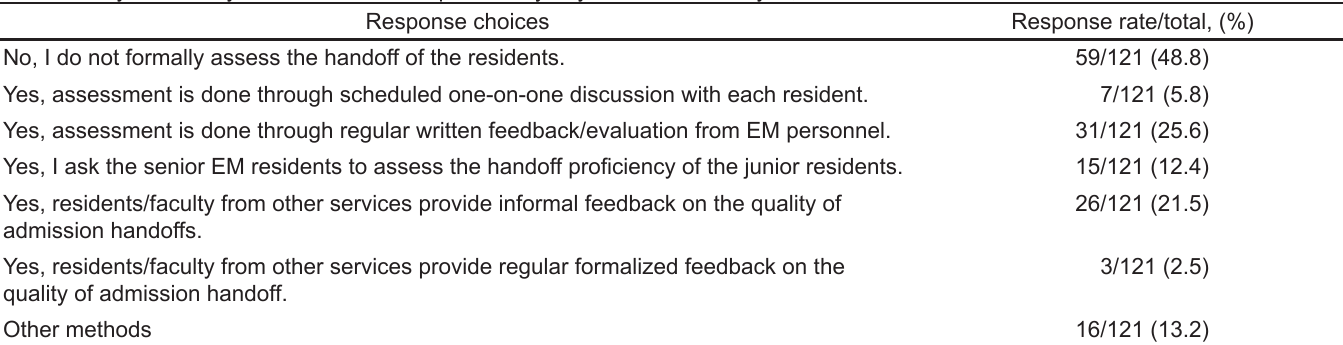
Table 2. Do you formally assess the handoff proficiency of your residents? If yes,